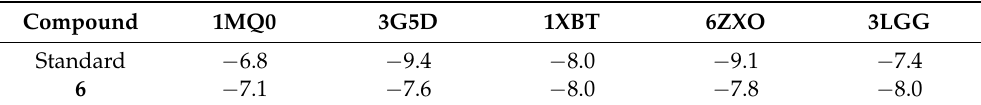
Table 4. Binding affinities (kcal/mol) of standard ligands and cytotoxic compound 6 against target proteins. Compound 1MQ0